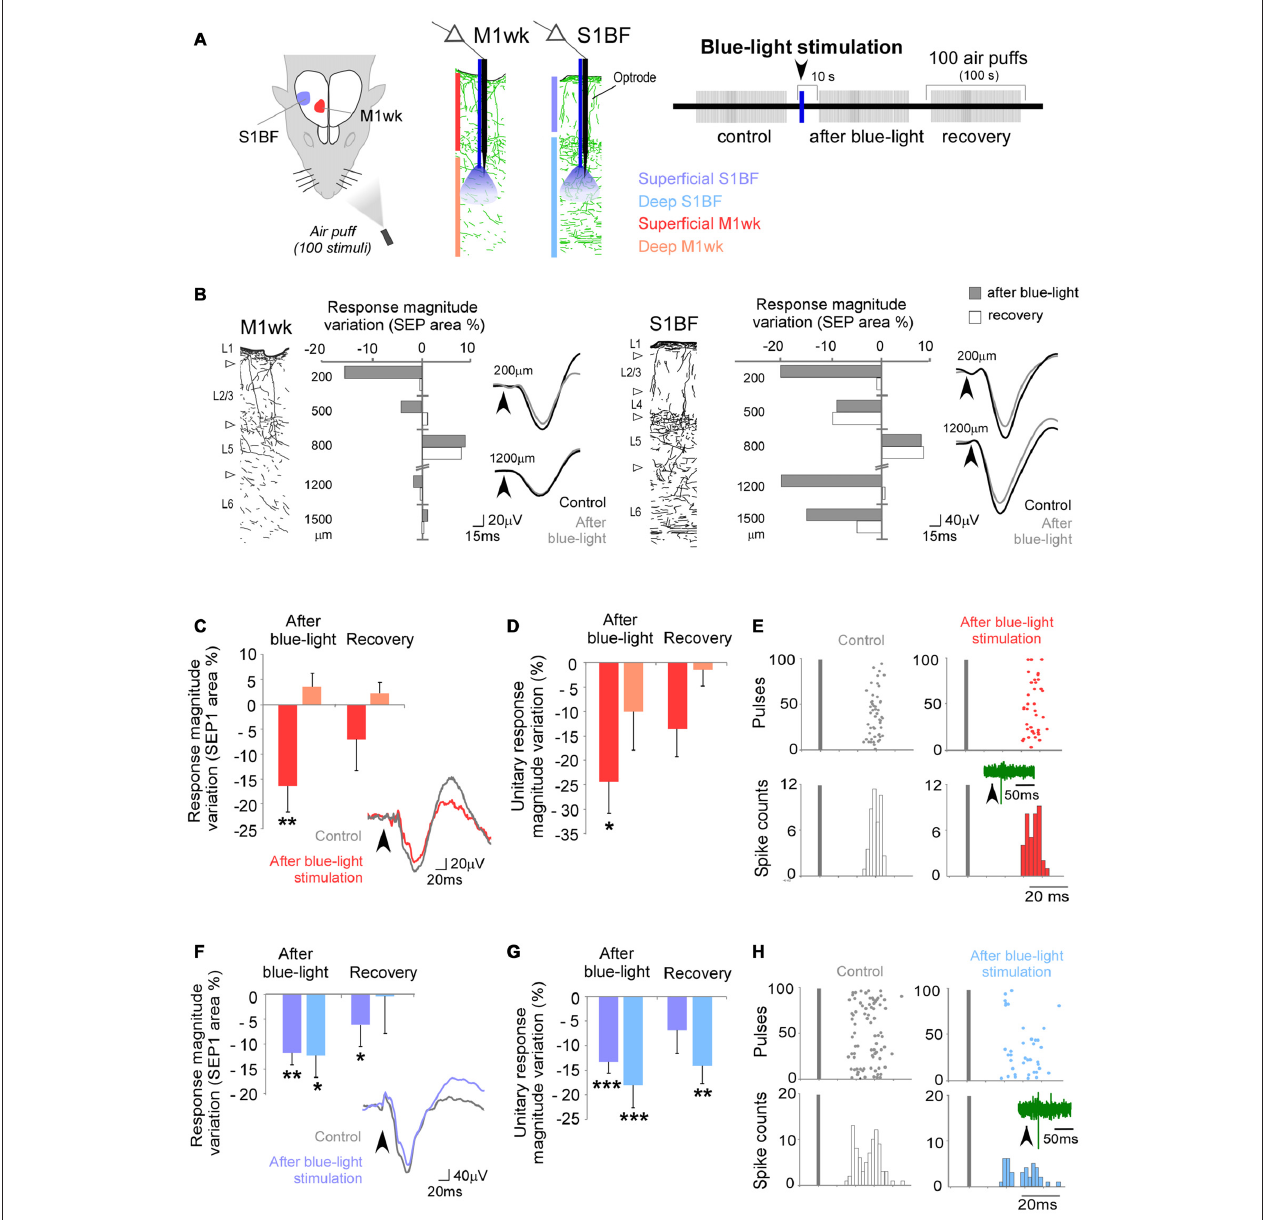
FIGURE 6 | Effects of selective optogenetic stimulation of Po terminal axons in particular layers of M1wk and S1BF cortices. (A) Diagram of the experimental protocol. A single pulse of blue-light (473 nm, 300 ms, < 30 mW/mm 2 ) was applied thought an optrode in the cortex to activate Po axonal terminals expressing ChR2 + eYFP. This blue-light pulse was applied immediately after the “control train” of whisker stimuli. SEPs and unit responses were recorded in the superficial and deep layers (shaded in different color hues, respectively) of S1BF (blue) and M1wk (red) cortices. (B) A representative case of these experiments displaying a different laminar innervation pattern and Po effects on tactile responses in M1wk and S1BF cortices. Cortical columns with immunolabeled Po axons are drawn for each area. Changes in SEP1 area immediately after blue-light application (gray) and during the recovery train (second train after Po stimulation; white) are represented as the variation of percentage to the control values in different cortical depths. Negative values symbolize inhibition and positive values facilitation. Representative trace examples of SEPs recorded during control (black line) and after blue-light (gray dashed line) pulses are shown on the right. (C) Blue-light activation of Po axons modulates SEP1 in M1wk. Mean values of changes in SEP1 curves area are represented as the variation of percentage to the control values. Examples of SEPs during the control (gray line) and after blue-light application (red line) are shown on the right. Grey bar indicates whisker stimuli application. (D) Mean values of changes in unit responses are represented as the variation of spike counts percentage to the control train. (E) Examples of PSTH and raster plots during the control (white) and after blue-light application (red) in superficial layers are shown. Representative spike traces are shown inside PSTH. Bars indicate whisker stimuli. (F) Blue-light activation of Po axons also modulates SEP1 in S1BF. Conventions as in panel (C) , except the example of SEPs after blue-light application is shown as blue line. (G) Unit whisker responses in S1BF. Conventions as in panel (D) . (H) Examples of PSTHs and raster plot of S1BF responses. Conventions as in panel (E) , except that both represent example of deep layers, and the PSTH and raster plot following blue-light application are represented in blue.